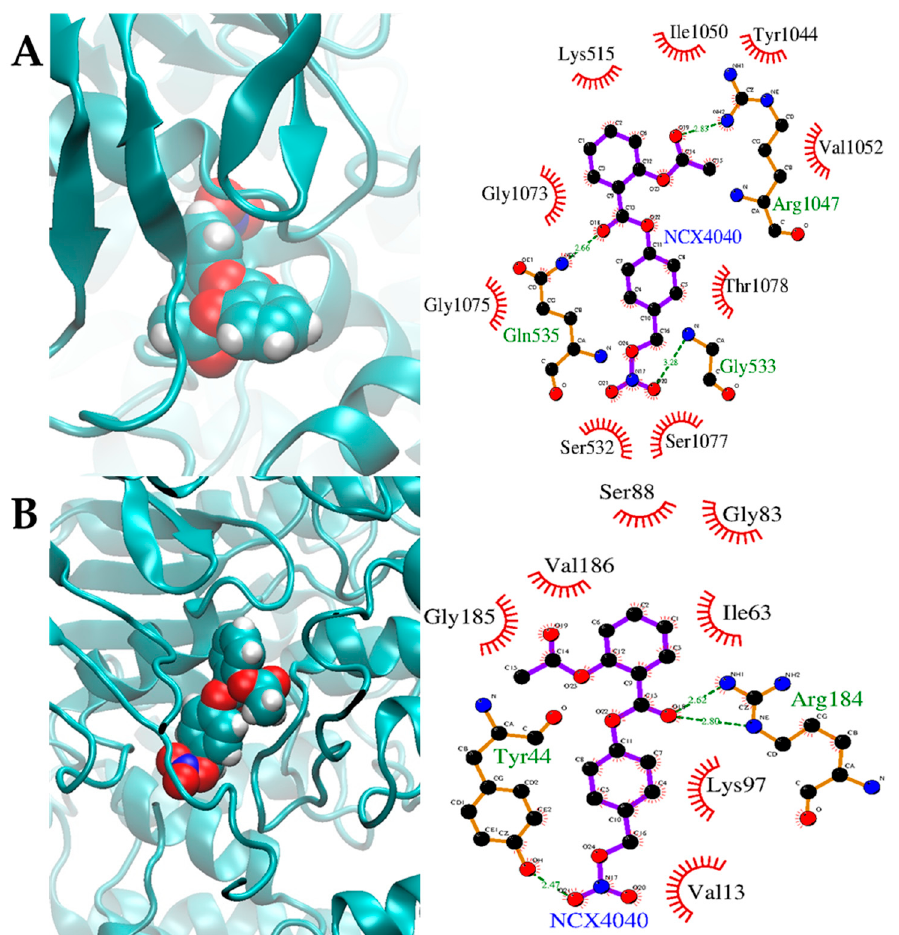
Figure 10. NCX4040 docked on ( A ) P-gp (pdb ID: 6C0V.pdb) ( B ) BCRP (pdb ID: 6hbu.pdb). NCX4040 is shown in solid spheres and the proteins are represented by ribbon diagrams. Residues of the protein that are in contact or making H-bonds are shown in right panels. Table 1. Ligand interaction scores of NCX-4040, SIN1, S-Nitroso glutathione, and ATP. Contributions from shape, H-bond, protein desolvation, and ligand desolvation sum up to the total binding score. * Binding of ATP to the modified S-NO- Cys of the ATPase in P-gp, resulting from the reaction of NO generated from NO-donors as proposed previously [11]. Receptor Ligand Total Shape H-Bond Protein Desolvation Ligand Desolvation P-gp ATP